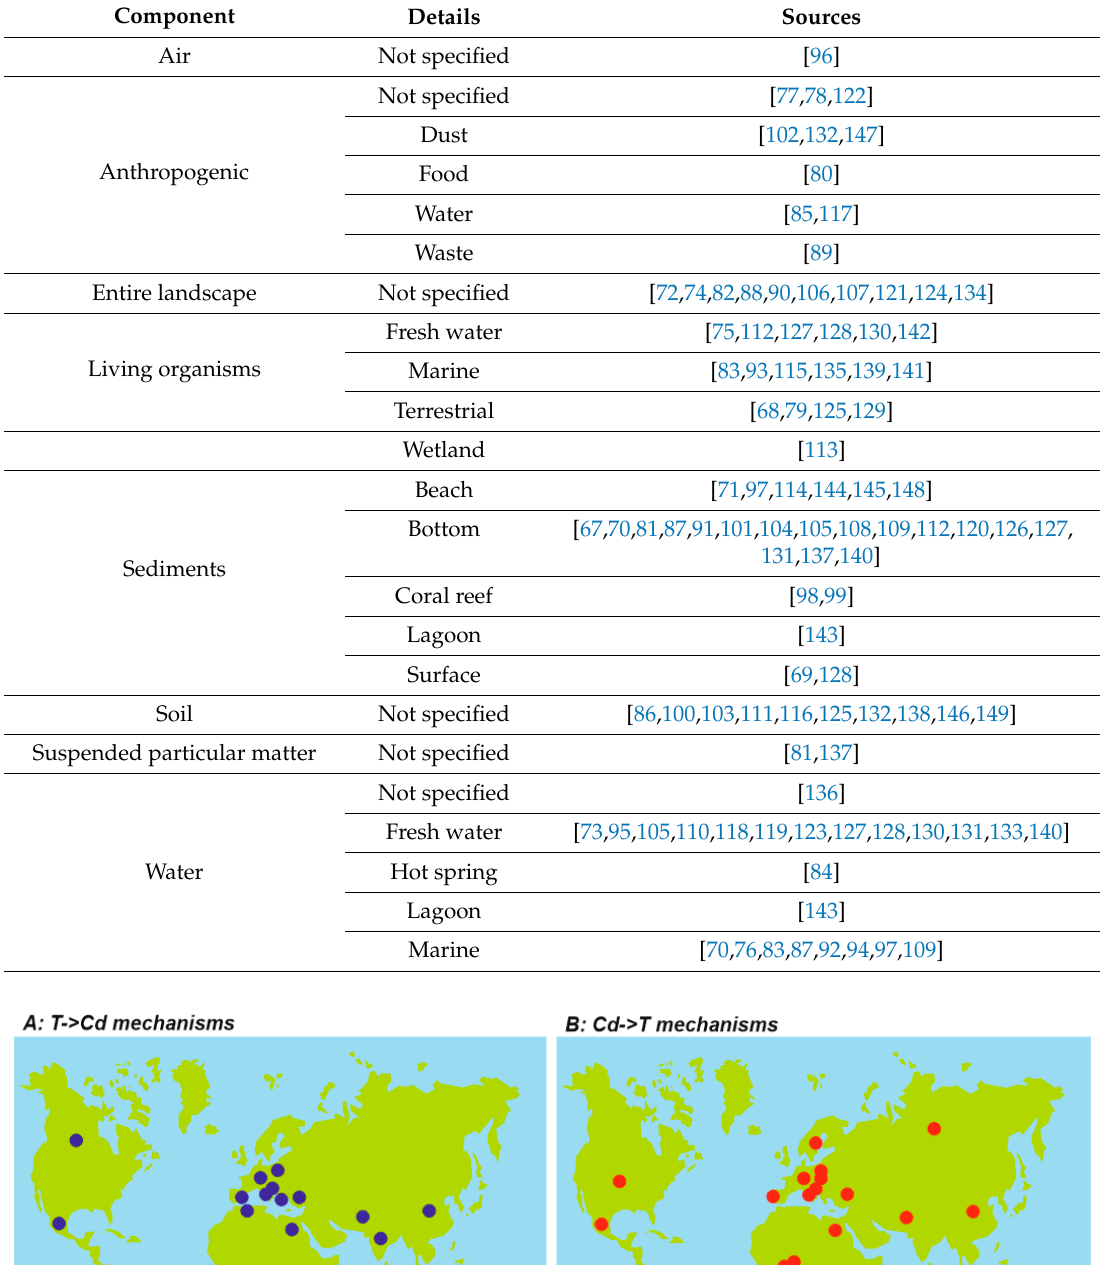
Table 2. Principal environmental components relevant to the cadmium–tourism relationships in the studies under review.